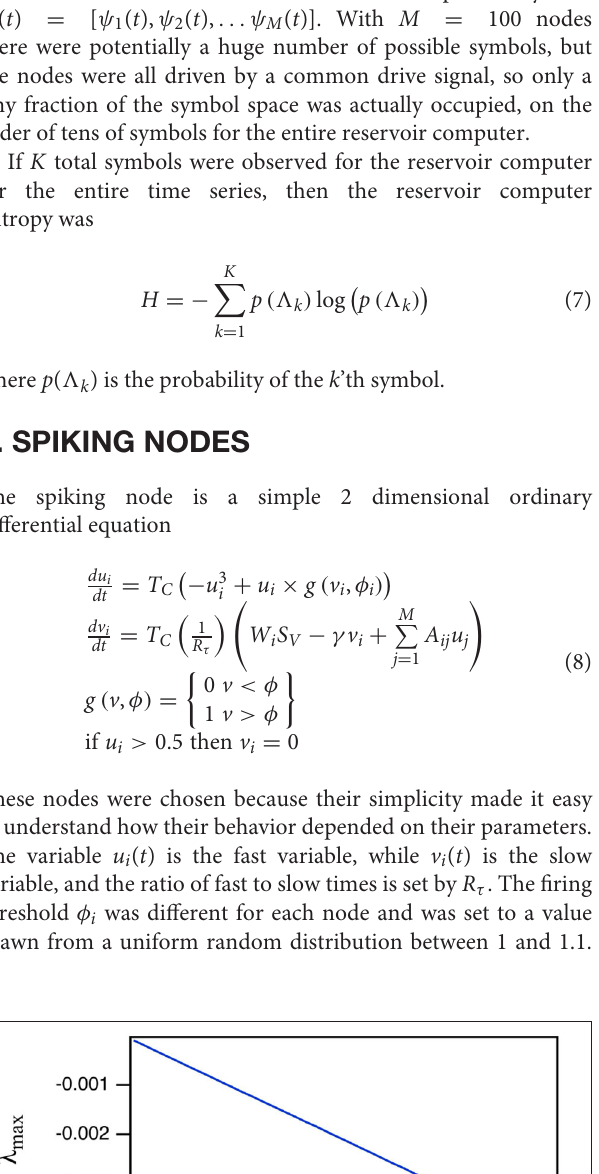
Frontiers in Physiology |